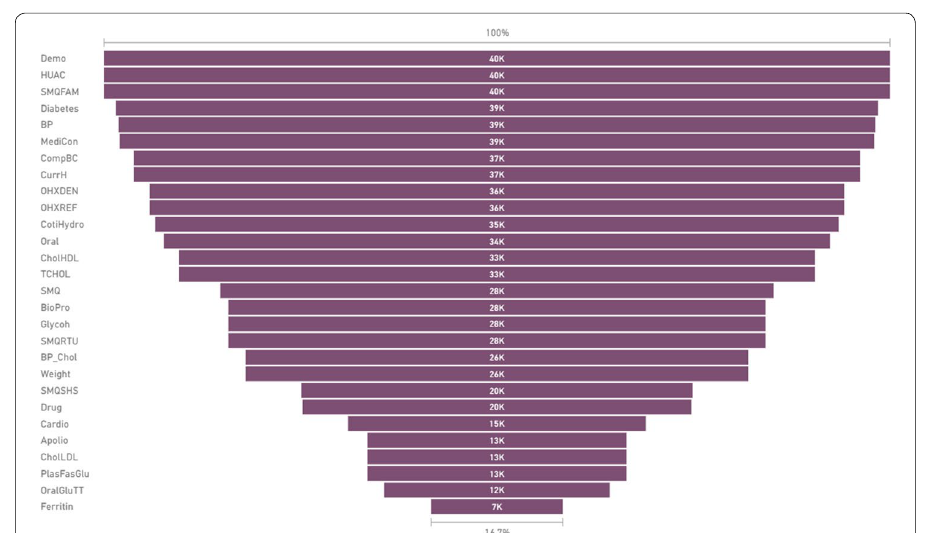
Fig. 5 Counts of patients per category in NHANES data for 2009